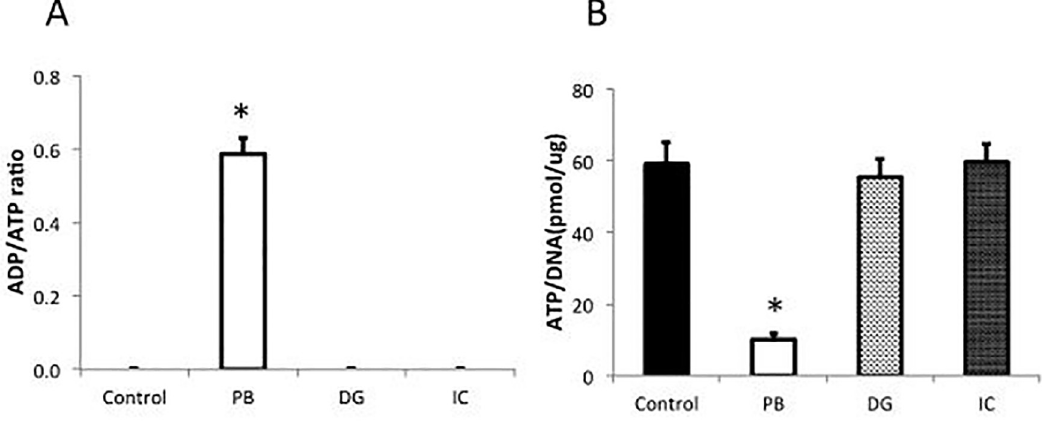
Fig 2. Toxicity of each dye to rat islets. (A) ADP/ATP ratio: The ADP/ATP ratio was significantly higher in the PB group than the other groups (n = 5, � p < 0.05). (B) ATP/DNA ratio: The ATP/DNA ratio was significantly lower in the PB group than the other groups (n = 6, � p <